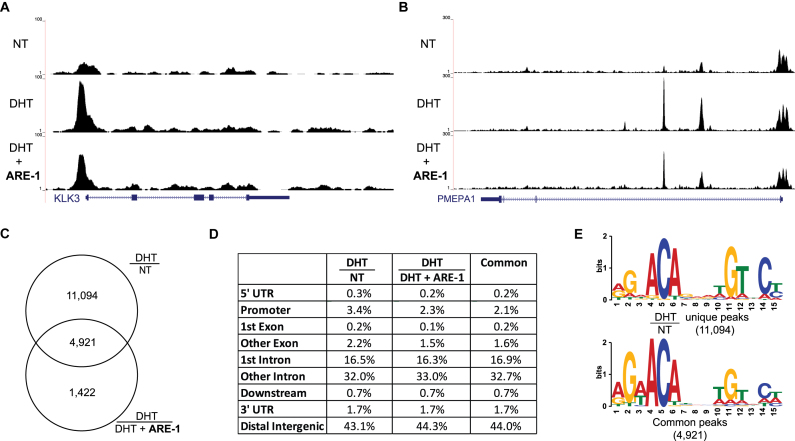
ChIP-seq analysis of the KLK3 promoter ARE I (A) and PMEPA1 (B). (C) Overlap of peaks differentially changed in DHT relative to NT, and peaks changed in DHT relative to DHT and ARE-1. (D) Identified peaks were annotated by genomic region by ChIPseeker. (E) Top ARE motif found by MEME in the indicated peak sets.